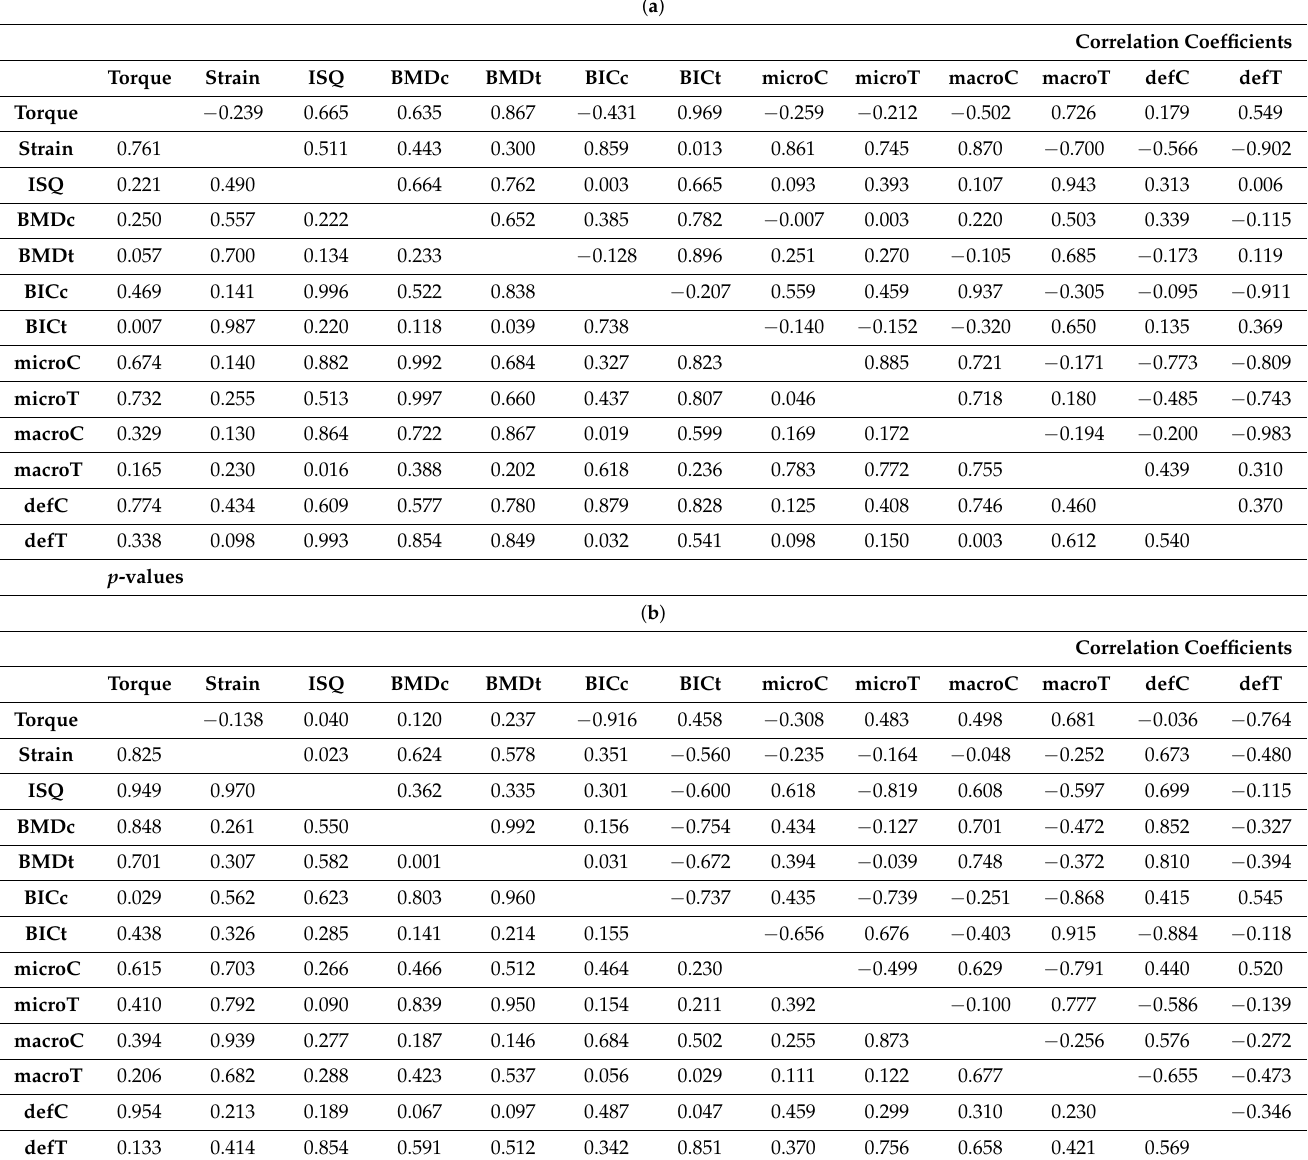
Table 3. ( a ) Pearson product moment correlation coefficients for measurement parameters recorded in ASTRA implants. ( b ) Pearson product moment correlation coefficients for measurement parameters recorded in Straumann